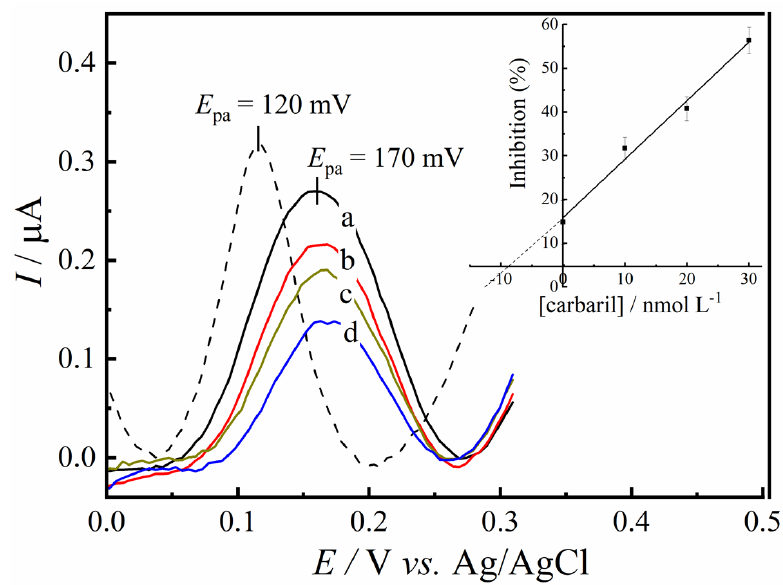
Figure 9. Proposed standard method addition for detecting carbaryl in apple samples. DPV responses in the absence (dashed line), apple sample fortified with 10.0 nmol L − 1 of carbaryl (a), and spiked carbaryl concentrations of 10.0, 20.0, and 30.0 nmol L − 1 (b–d).